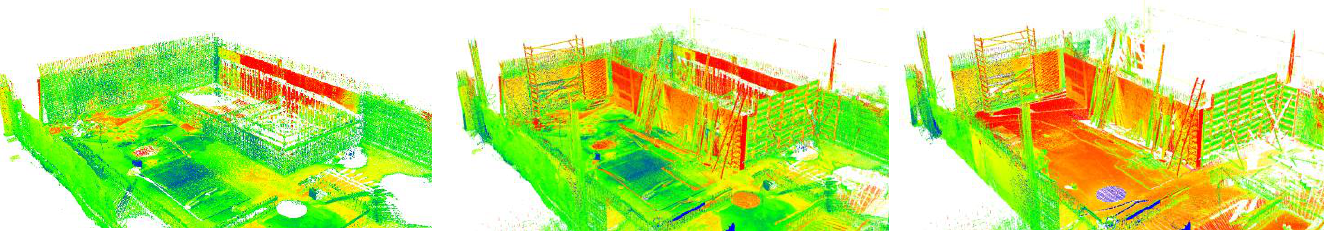
Figure 4a: Point Cloud Data of consecutive epochs at an interval of 2 weeks: (left) week 22, (middle) week 24 and (right) week 26. The point clouds are colorized according to their acquired intensity values. Red indicates poor measurements while blue depicts high quality points.